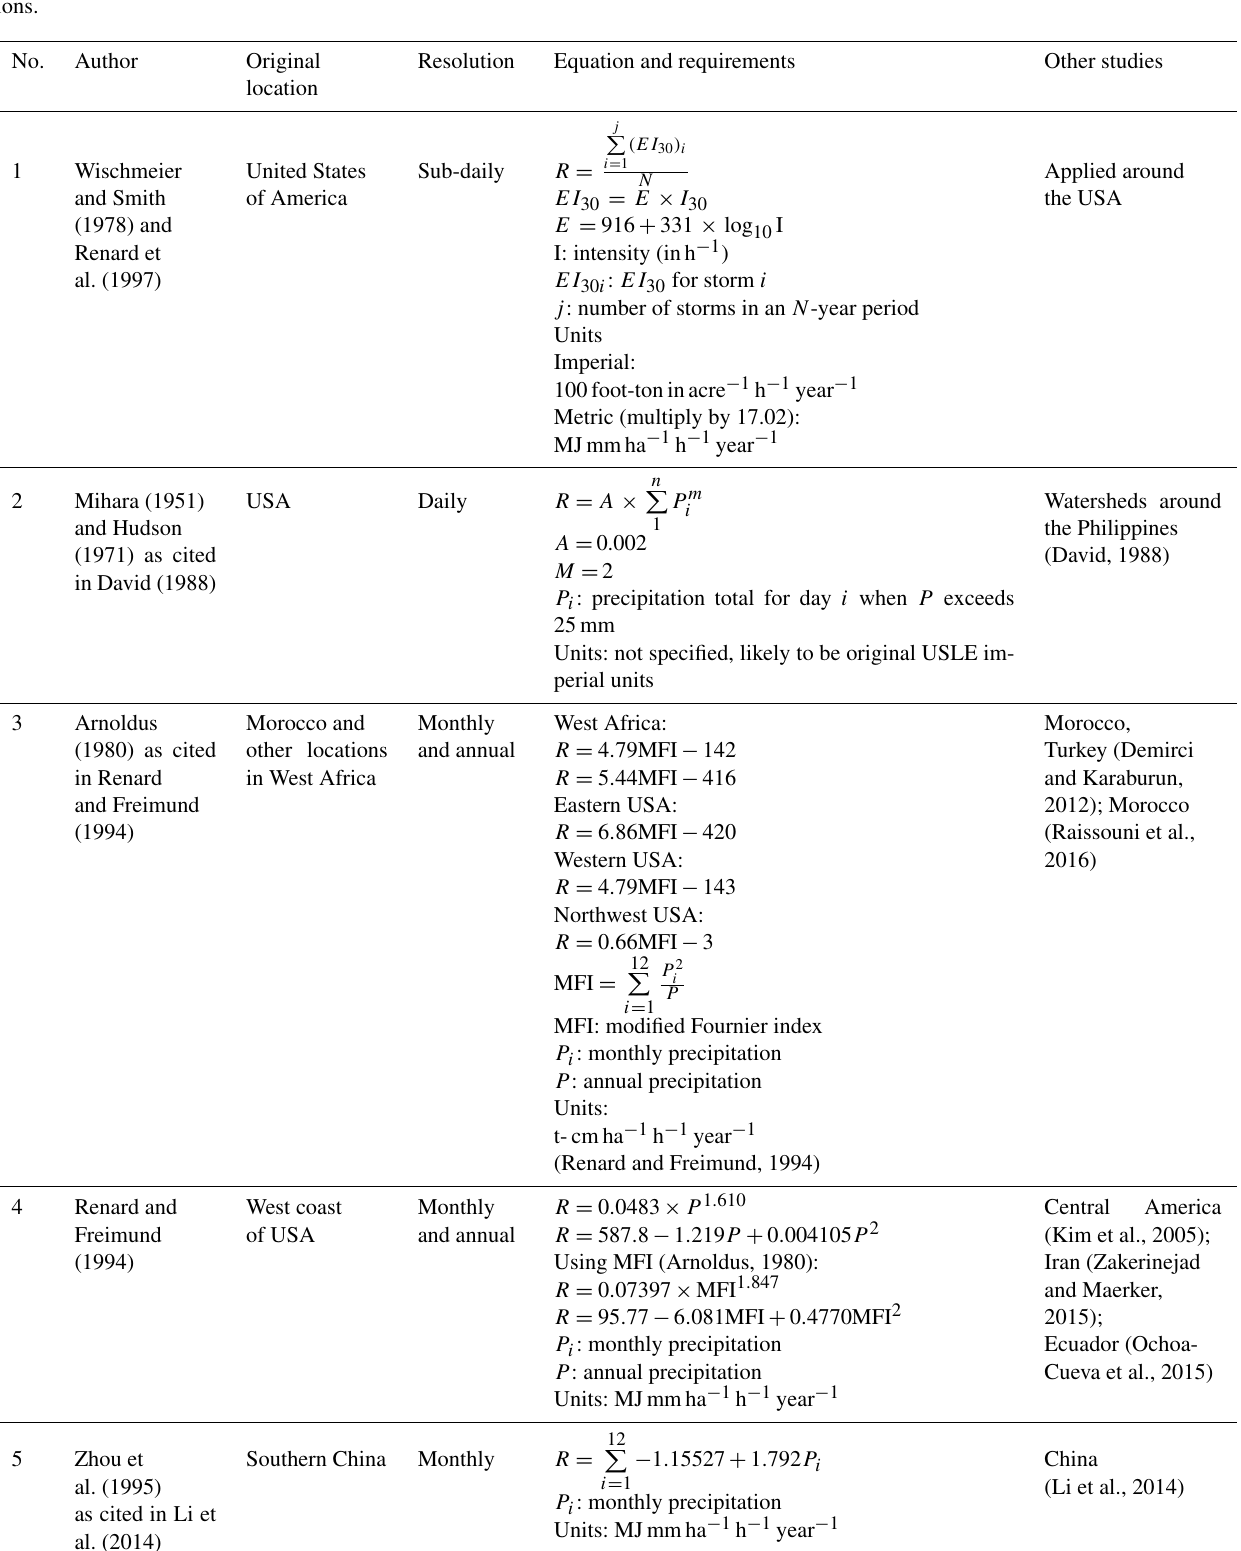
Table 2. Summary of different studies that developed rainfall erosivity equations, original locations, and other studies that used their equa-